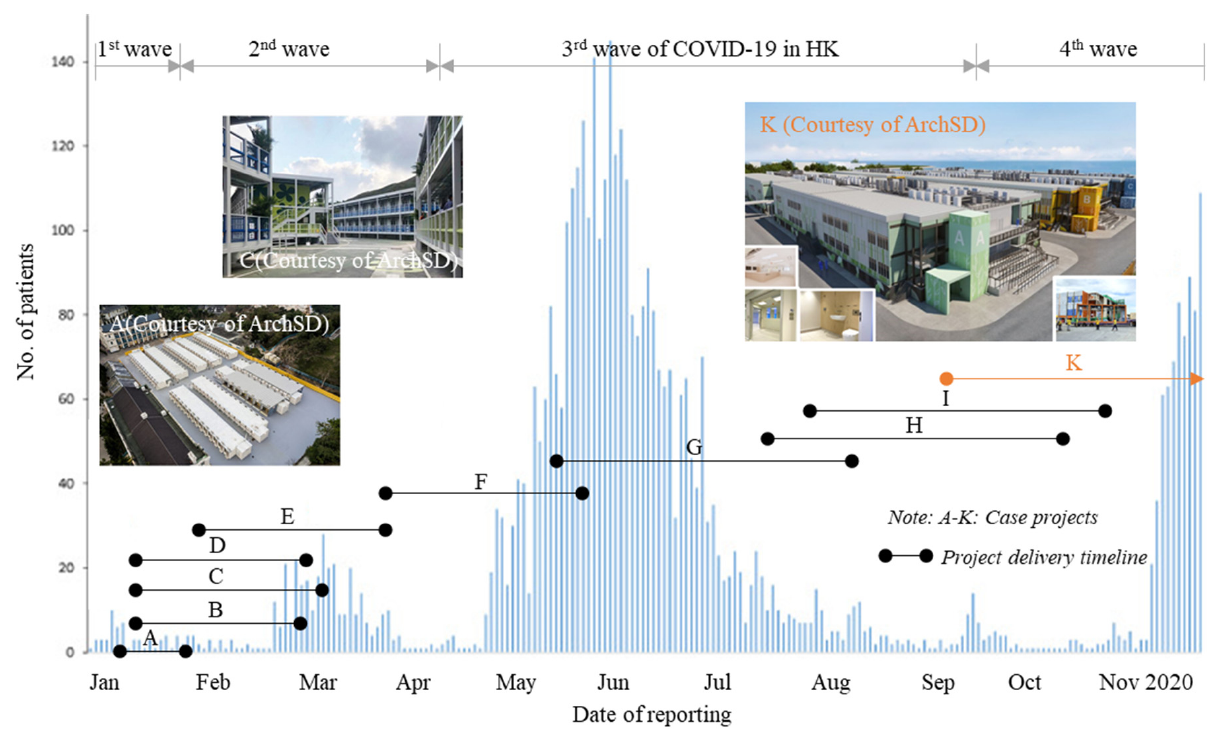
Figure 3. Timeline of project delivery and waves of COVID-19 in Hong Kong.